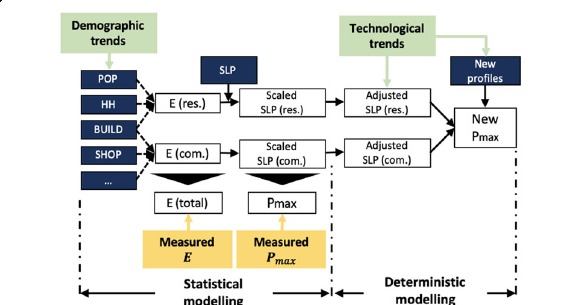
Fig. 1 (abstract P7). Overview of the model (blue: data inputs; yellow: dependent variables; green: scenarios for prediction; dashed arrows: unknown